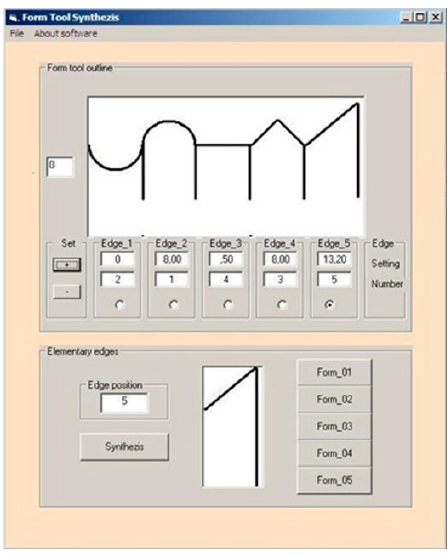
Figure 3. Screenshot of the Tool_Shape software for insert selection and positioning.